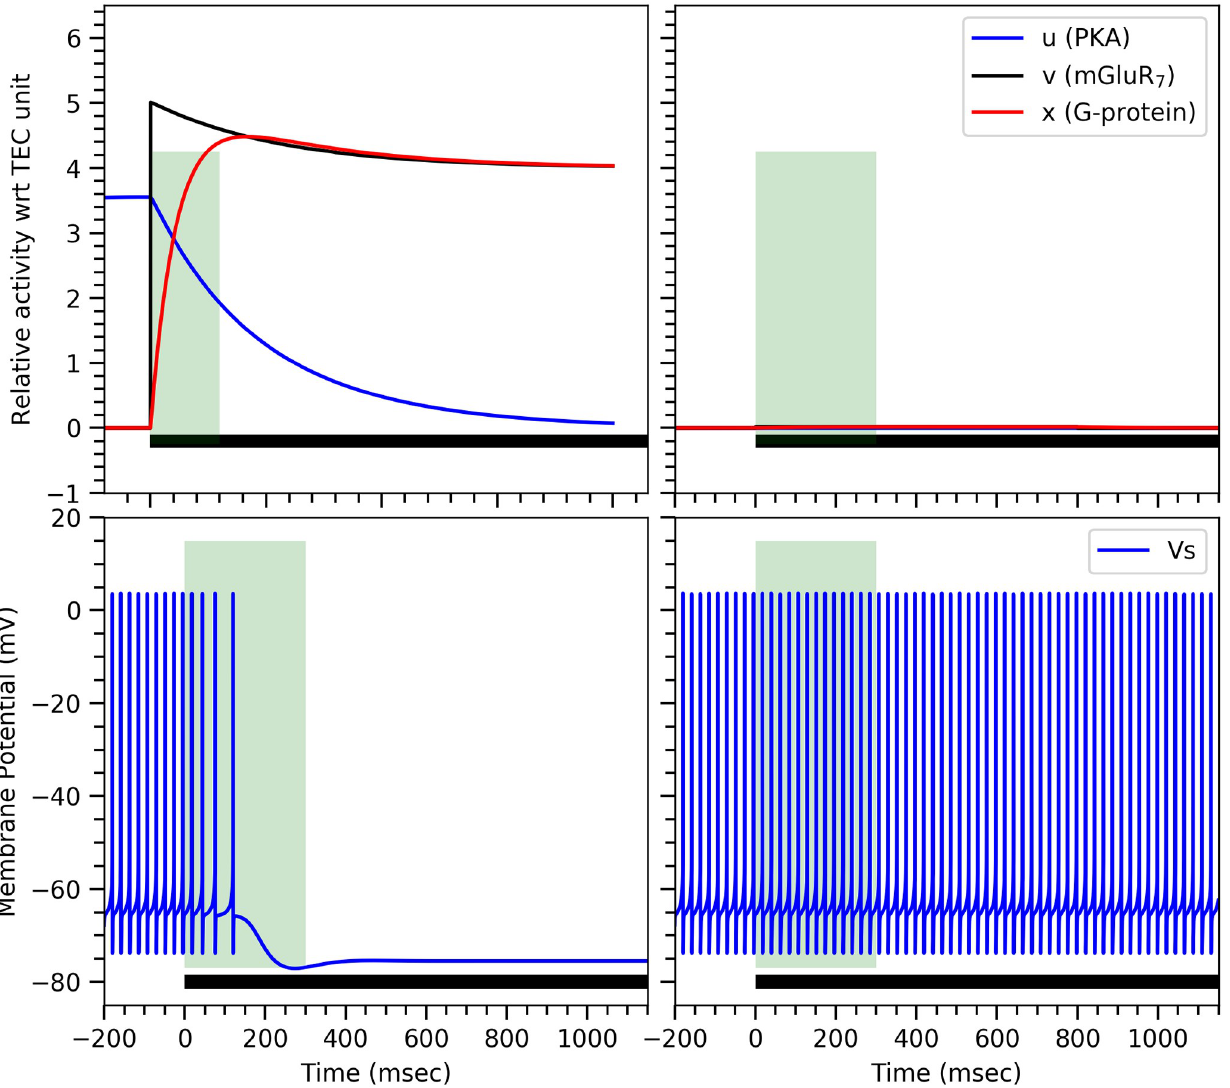
Fig 9. Model predictions for knockout experiments. In our minimal model, PP1 can be knocked out by setting w 0 = 0.0 at the onset of stimulus (top left panel), which prevents the Purkinje cell to fire again after the initiation of the conditional response (bottom left panel). PKA can be knocked out by setting u 0 = 0.0 in our model (top right panel), which prevents the Purkinje cell to initiate a conditional response (bottom right panel).